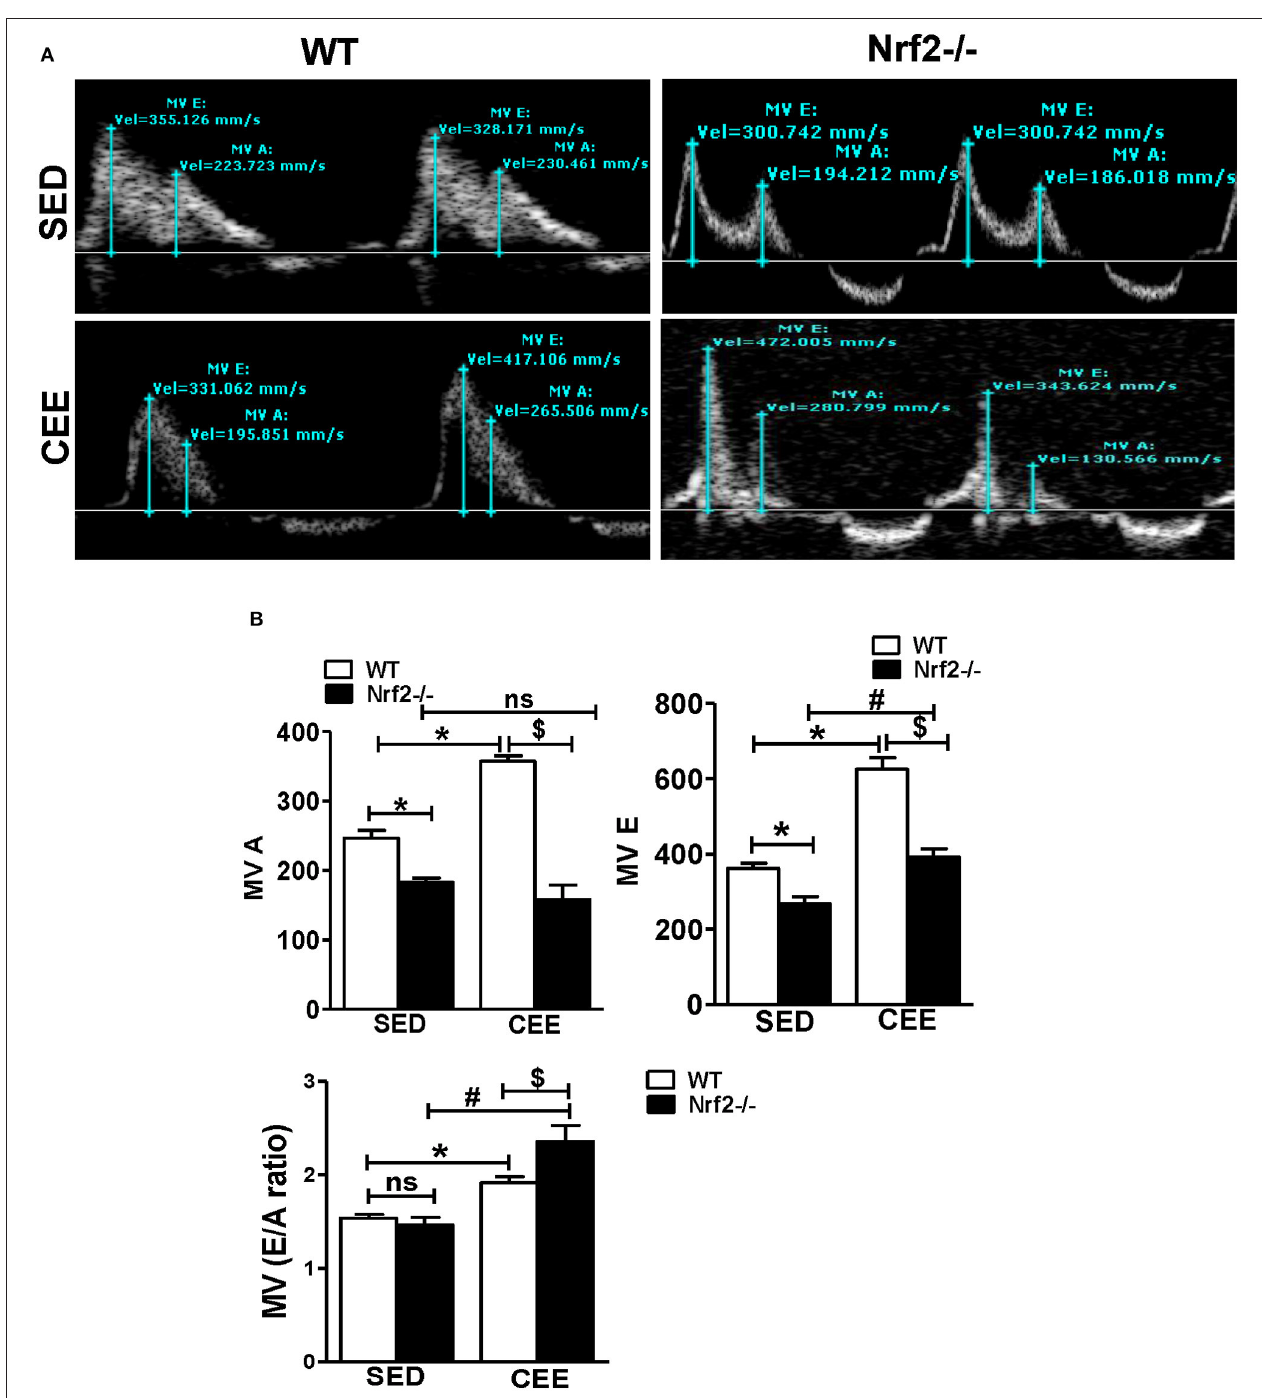
FIGURE 8 | Chronic endurance exercise prompts diastolic dysfunction in aged mice: Diastolic dysfunction was measured by placing the pulse wave Doppler across the mitral valve and mitral valve inflow was measured in aged WT and Nrf2 − / − mice under sedentary and exercise condition. (A) Representative pulse wave Doppler images showing transmitral blood flow velocity patterns, (B) Mitral valve E-wave (early filling) and A-wave (late diastolic filling) patterns were measured using the mitral valve images and the mitral inflow pattern was derived from MV E/A ratio. The bars in the histogram represent the mean ± SD for each sample and the statistical difference is indicated as p -value obtained from the one-way ANOVA followed by Tukey multiple comparison tests ( * P < 0.05 vs. WT-SED, # P < 0.05 vs. Nrf2 − / − -SED, $ P < 0.05 vs. WT CEE).